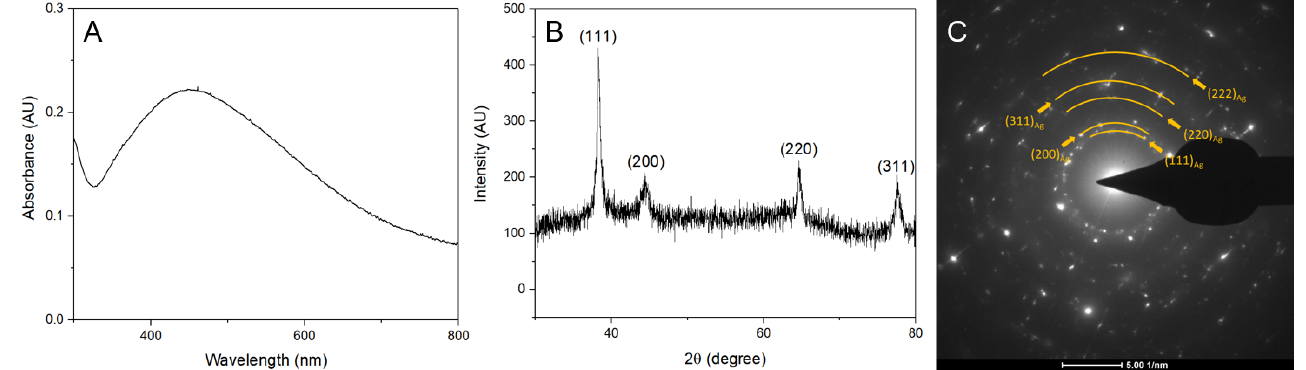
Figure 3. Characterization of the AgNPs synthesized with orange peel extract. ( A ) UV-vis absorbance spectrum of the AgNPs. ( B ) XRD pattern of the AgNPs with labeled diffraction peaks. ( C ) SAED pattern of the AgNPs with the rings labeled.